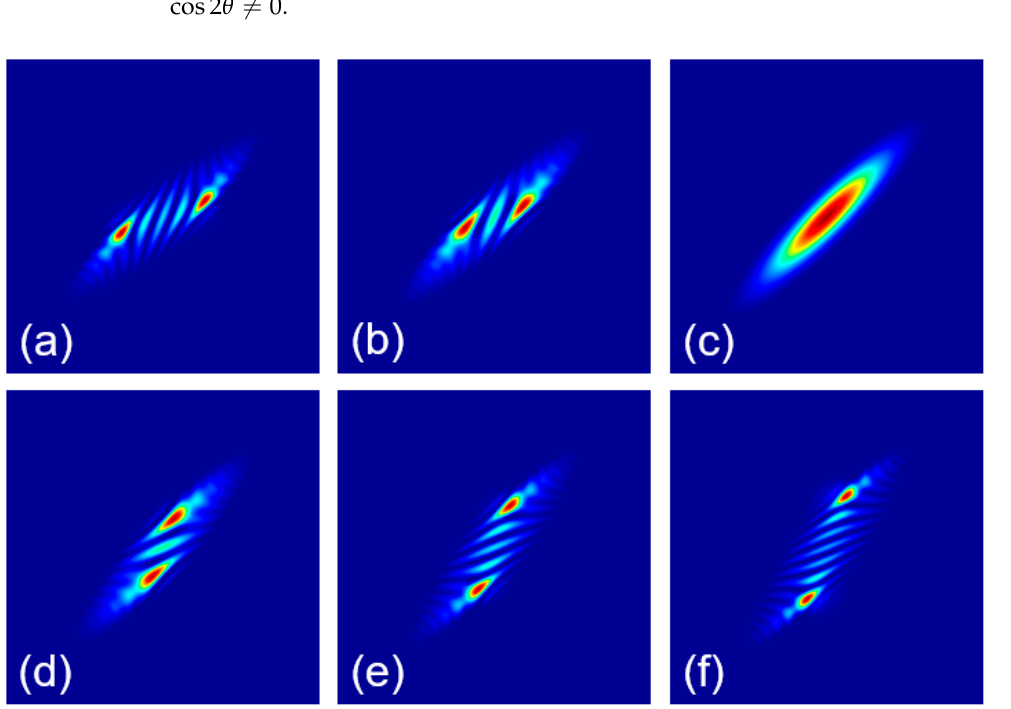
Figure 7. The spectral density and DOC of the RAGSM beam rotate during transmission, even back to the original angle, which is called reversal rotation. Whether reversal rotation distribution of beam source [52].